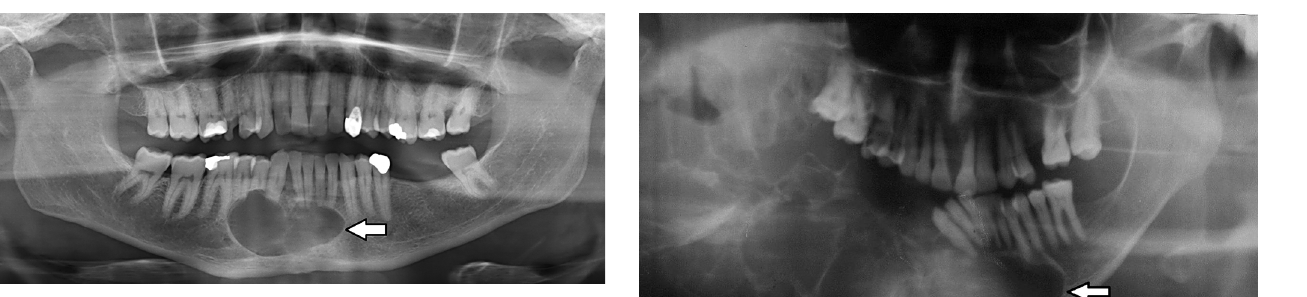
Fig. 3. Pantomograph showing unilocular ameloblastoma in the anterior mandible with signs of root resorption.